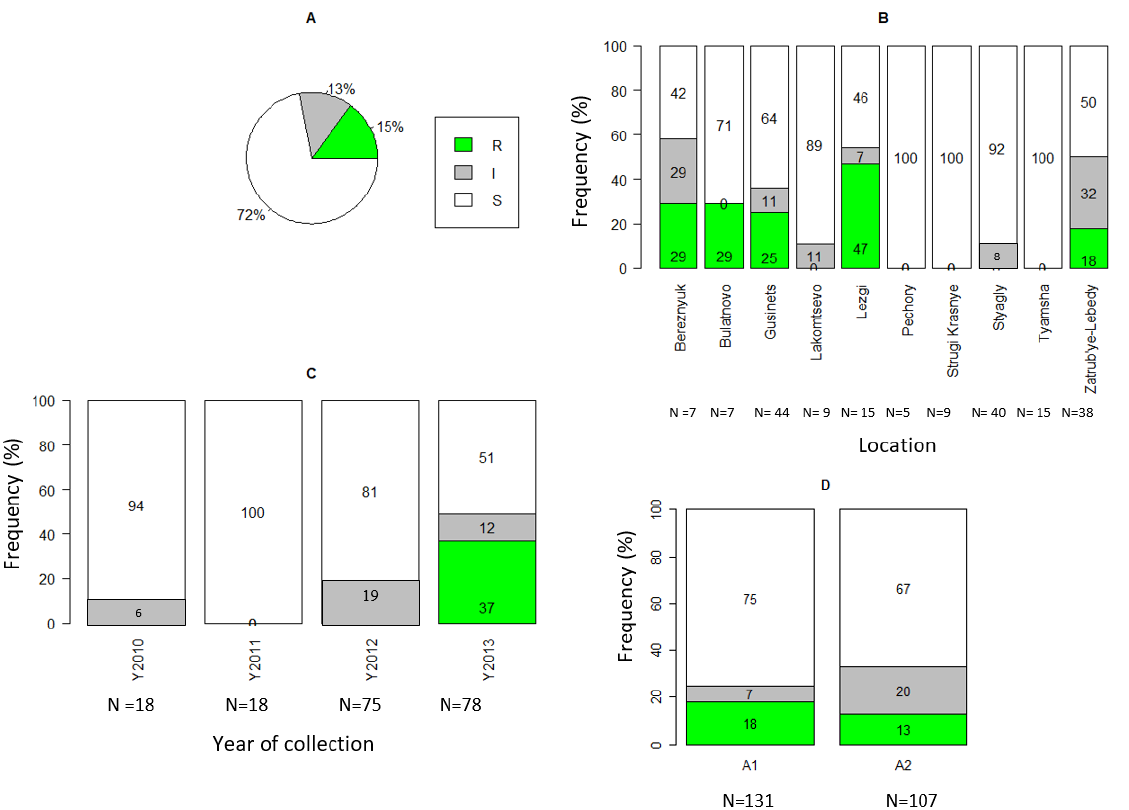
Figure 3. Metalaxyl resistance among P. infestans isolates collected from Pskov region in north-west Russia during 2010–2013. ( A ) For all tested isolates. ( B ) For locations. ( C ) For sampling years. ( D ) For A1 and A2 mating type. R: resistant, I: intermediate, S: sensitive. Note: Number in parenthesis in Figure 3B is the number of isolates.